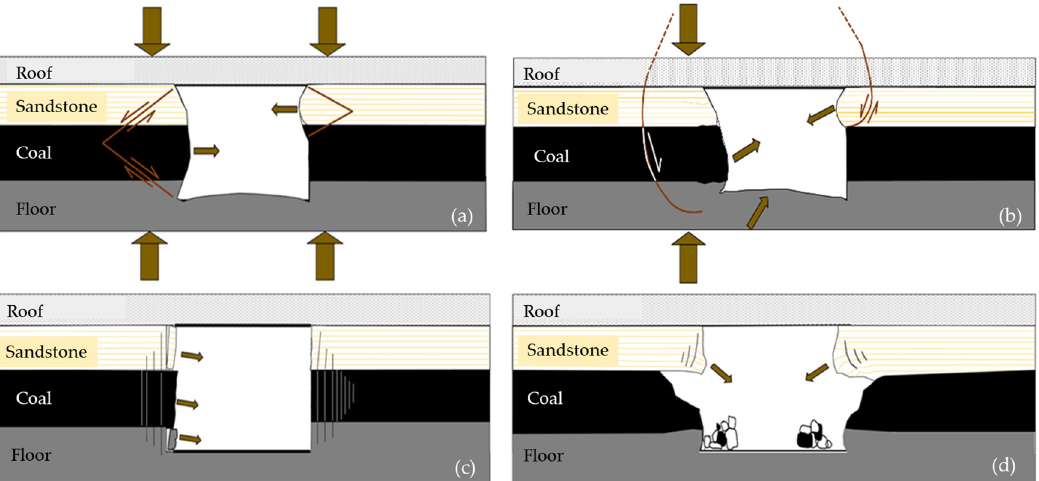
Figure 4. Example rib deformation characteristics: ( a ) compressive-driven rib failure, ( b ) shear-driven rib failure, ( c ) slabbing rib failure, and ( d ) toppling failure (after [18]).